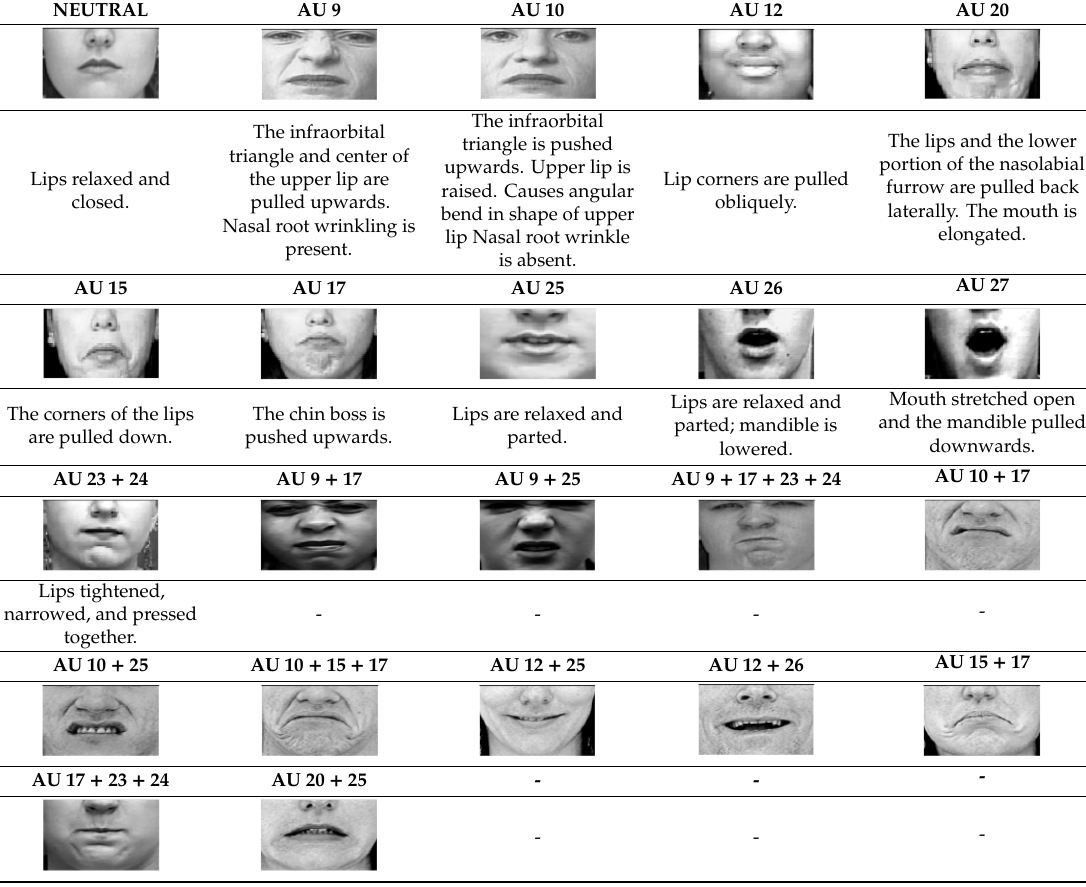
Table 3. Lower face action units and some combinations.